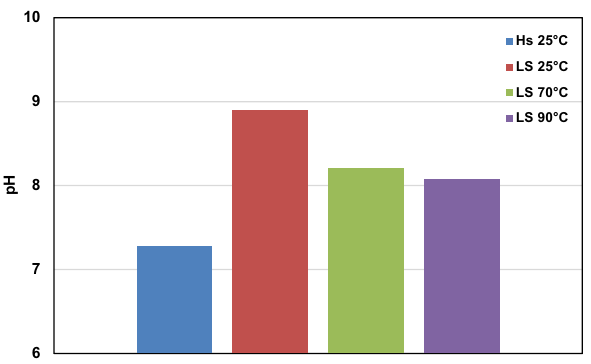
Fig. 7 Effluent pH profile at 25, 70, and 90 °C for (core#3)